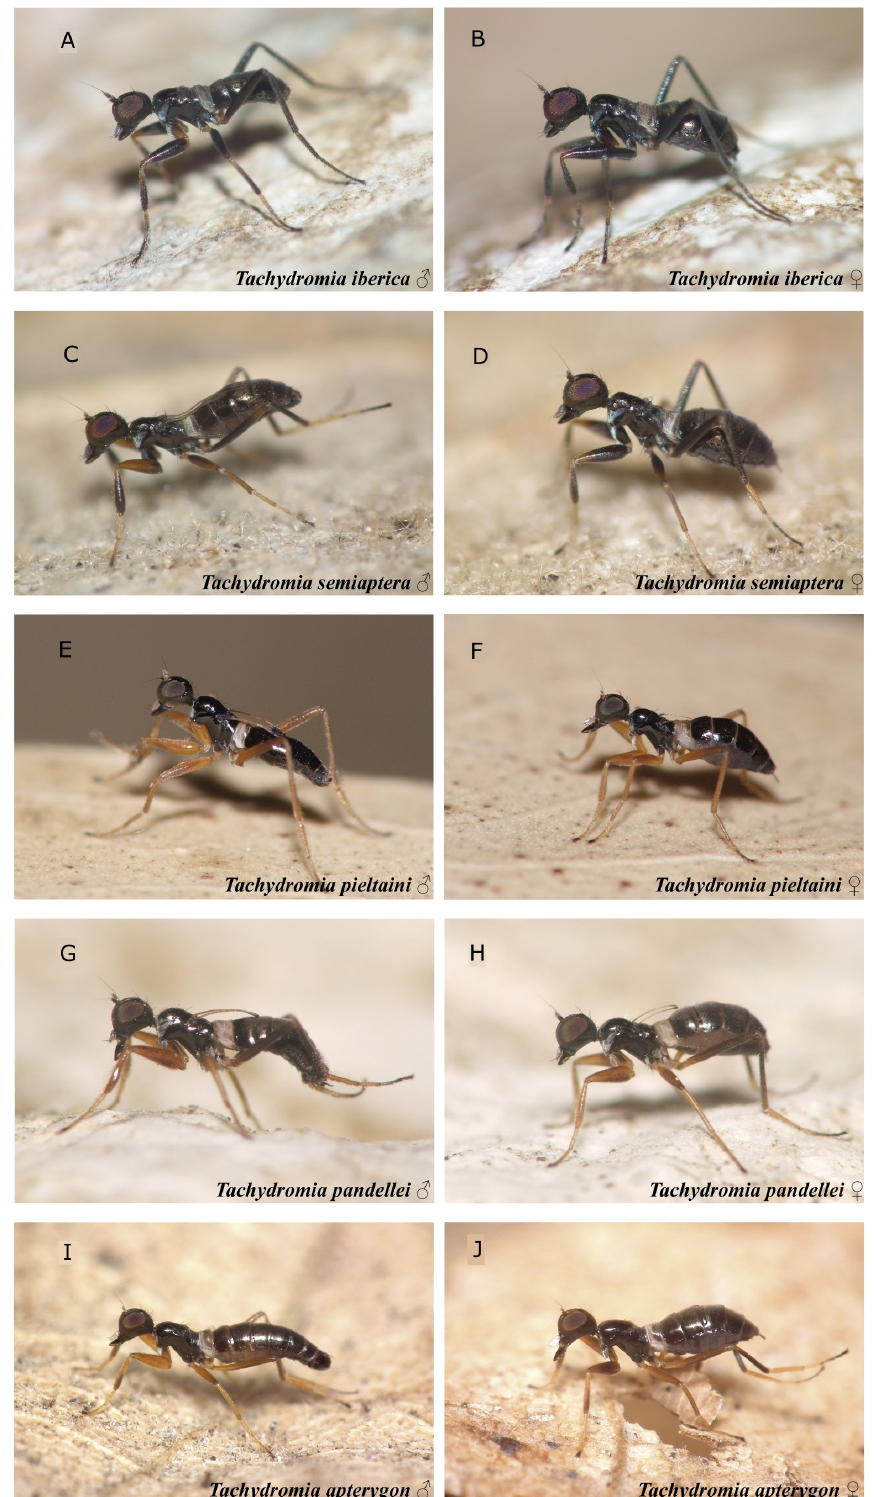
Fig. 16. Habitus of live specimens of the Iberian ant-like Tachydromia Meigen, 1803 and the Italian flightless Tachydromia . Males are pictured in the left column, females in the right. A–B . T. iberica